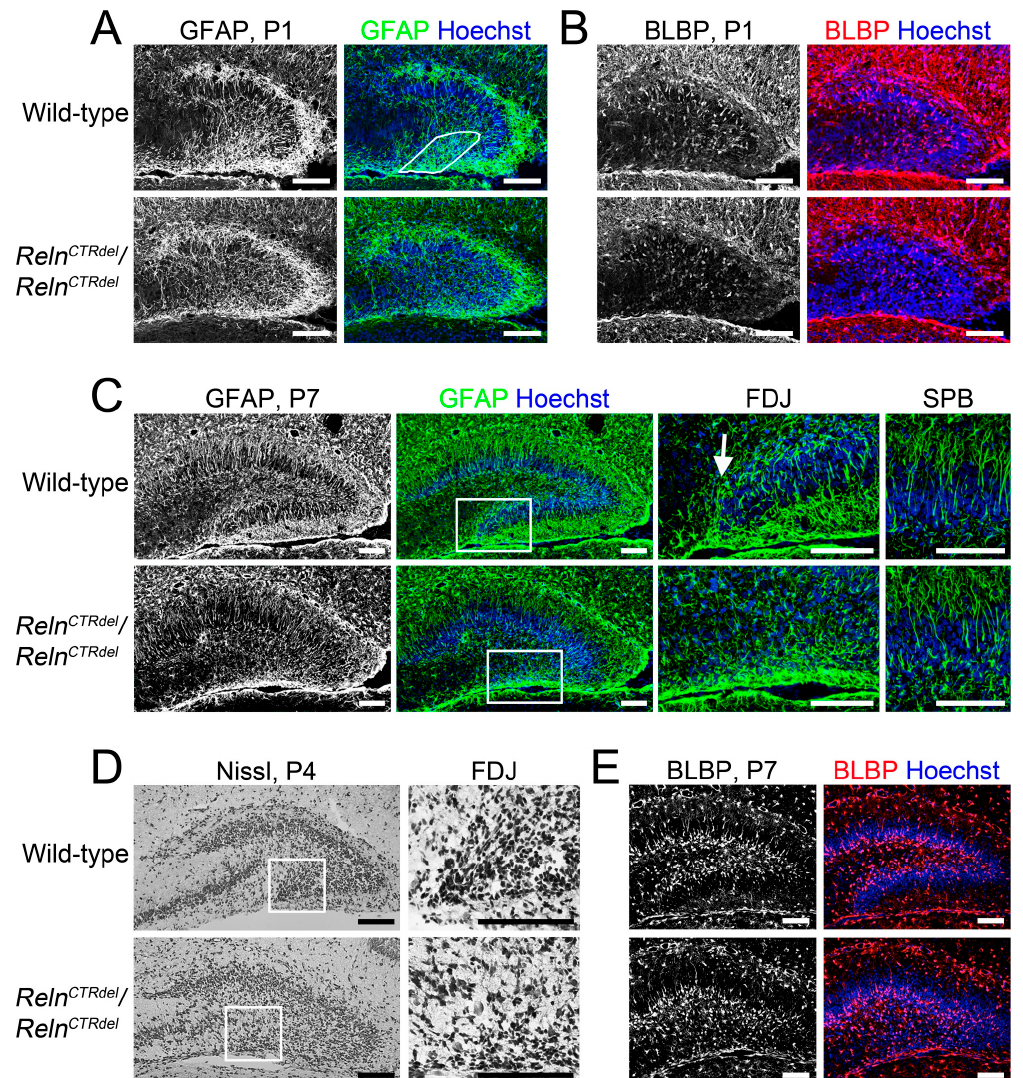
Figure 5. Lack of the secondary glial scaffold formation in the IPB. ( A ) At P1 when the secondary glial scaffold formation begins in the IPB, the mutant mice lack dense GFAP-stained fibers (gray or green, marked region) that are apparent near the fimbriodentate junction of wild-type mice ( n = 2 each). Note the premature secondary glial scaffold can be already seen in the SPB of both wild-type and mutant. ( B ) At P1, BLBP-positive cell bodies (gray or red) appear near the IPB in wild-type mice ( n = 2 each). Fewer BLBP-positive cells are found near the IPB of Reln CTRdel mice. ( C ) Images of GFAP-stained (gray or green) dentate gyrus at P7 (left, n = 2 each). Enlarged images of the boxed fimbriodentate junction (FDJ) regions are shown in the center. In wild-type mice, GFAP-positive fibers are surrounding the growing tip of the infrapyramidal blade at the fimbriodentate junction (arrow). This structure is absent in the mutant. The secondary glia scaffold in the SPB is relatively normal (right, higher-magnification images). ( D ) At P4, a stream of migrating cells with elongated morphology is absent in the mutant fimbriodentate junction ( n = 1 each). Enlarged images of the fimbriodentate junction regions are shown on the right. Nissl stain. ( E ) At P7, abnormal distribution of BLBP-positive cells (gray or red) in the hilus become more evident ( n = 2 each). The cells are directed toward the SPB in the mutant. Nuclei were stained using Hoechst (blue). Scale bars, 100 µm. Enlarged images of ( A ) (color panel), ( B ) (color panel), ( D ) (right panel), and ( E ) (color panel) can be found in Figure